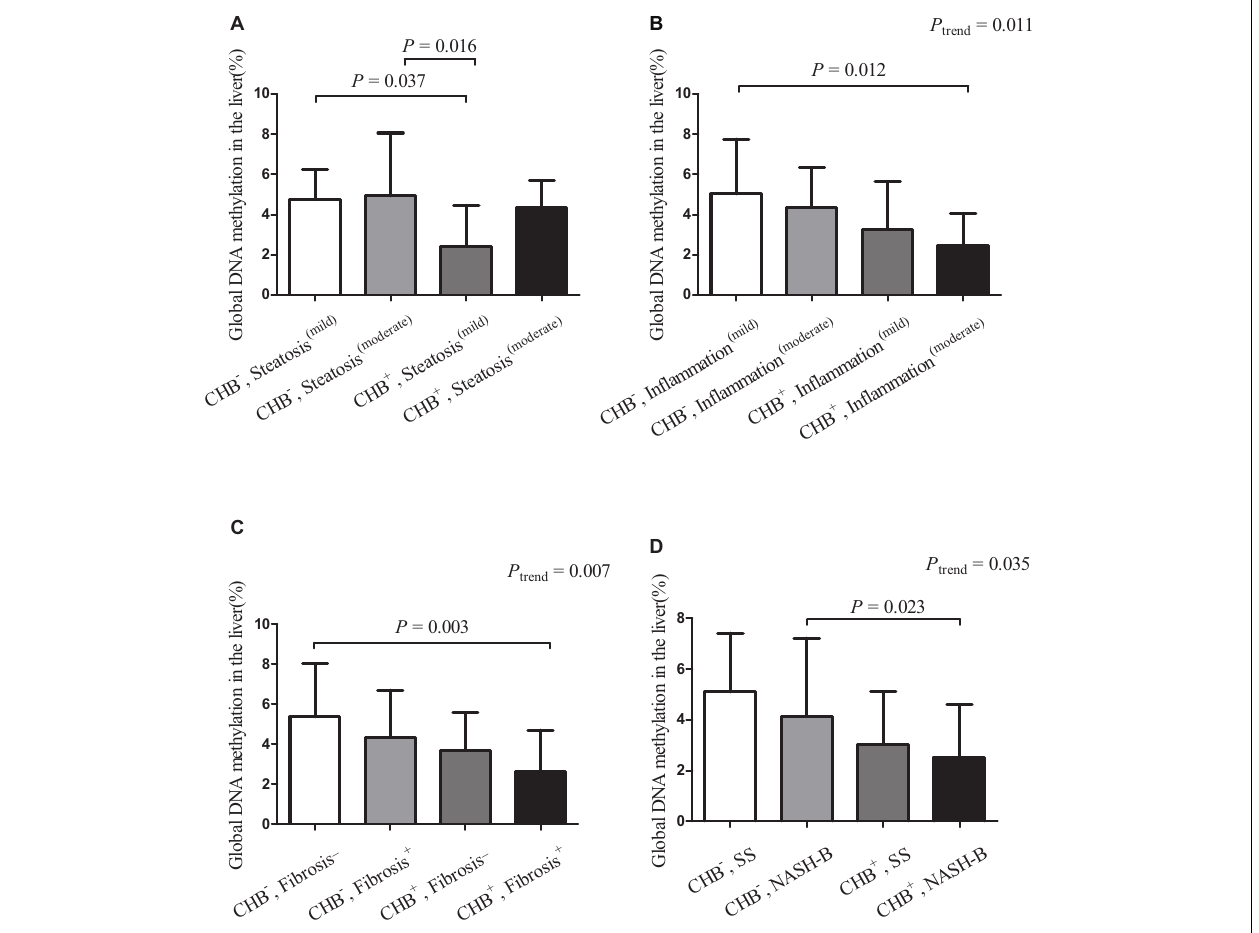
FIGURE 2 | Hepatic global DNA methylation levels in groups stratified by chronic hepatitis B status and histological characteristics ∗ . Data are expressed as means with standard deviation (SD). ∗ Hepatic global DNA methylation levels in groups, which were stratified by chronic hepatitis B status and steatosis grade (A) , inflammation grade (B) , the presence or absence of fibrosis (C) , NAFLD activity score (D) . CHB − , non-alcoholic fatty liver disease without chronic hepatitis B; CHB + , concurrent non-alcoholic fatty liver disease and chronic hepatitis B; Fibrosis − , without fibrosis; Fibrosis + , concurrent with fibrosis; Inflammation ( mild ) , mild inflammation (grades 0 and 1); Inflammation ( moderate ) , moderate inflammation (grades 2 and 3); NASH-B, steatohepatitis borderline; SS, simple steatosis; Steatosis ( mild ) , mild steatosis (grade 1); Steatosis ( moderate ) , moderate steatosis (grades 2 and 3).